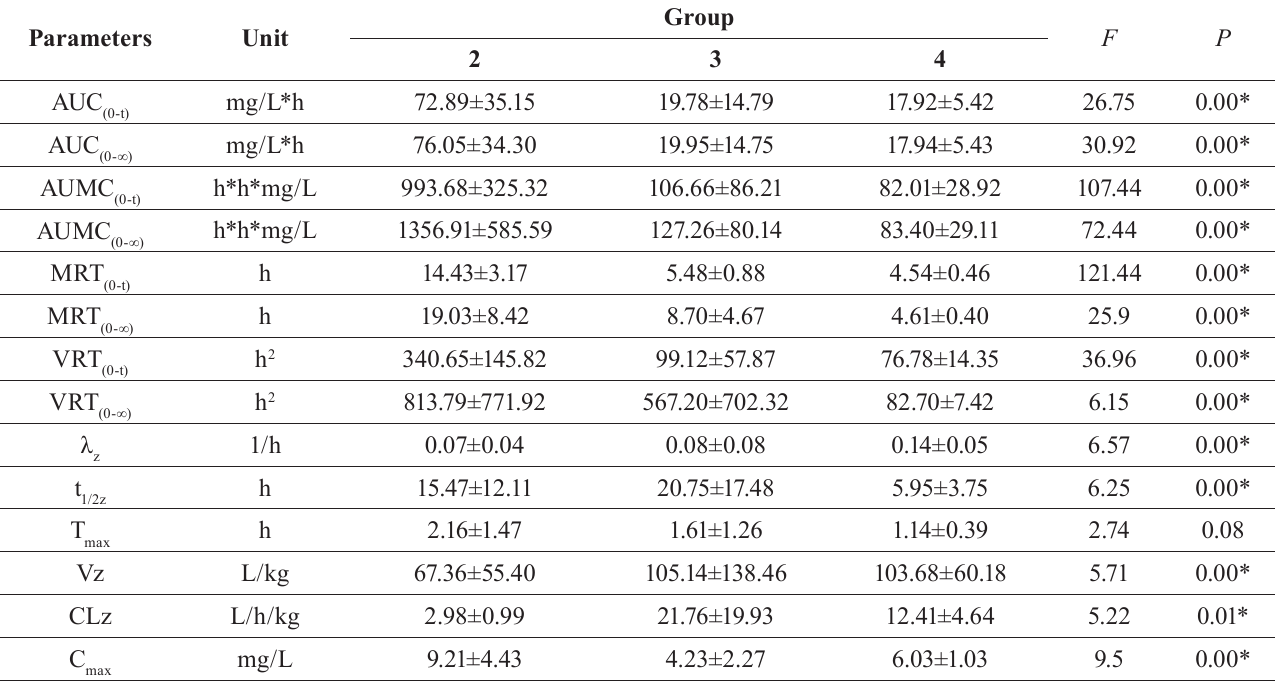
TABLE III - Kinetics parameters changes of groups ( )